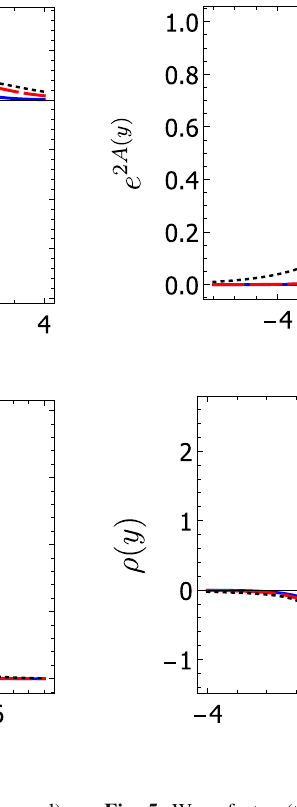
Fig. 5 Warp factor (top panel) and energy density (bottom panel) depicted for c = 1 . 2 and α = 0 (solid-line), α = 1 (dashed-line) and α = 2